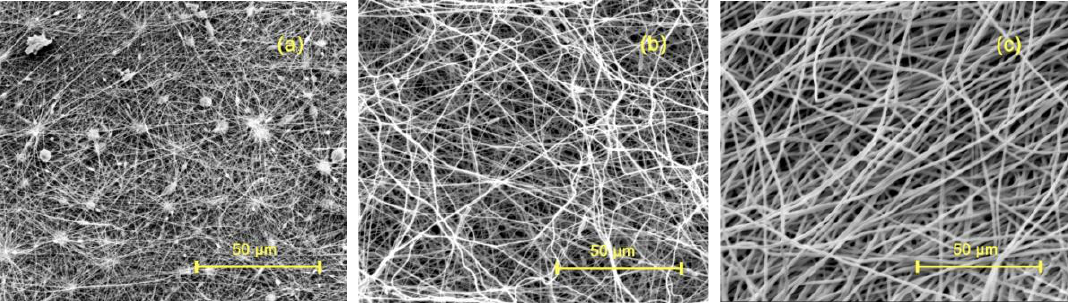
Figure 2. The effect of PAN mass fraction on the morphology of n-hemin/PAN: ( a ) 8%PAN, ( b ) 14% PAN, ( c )